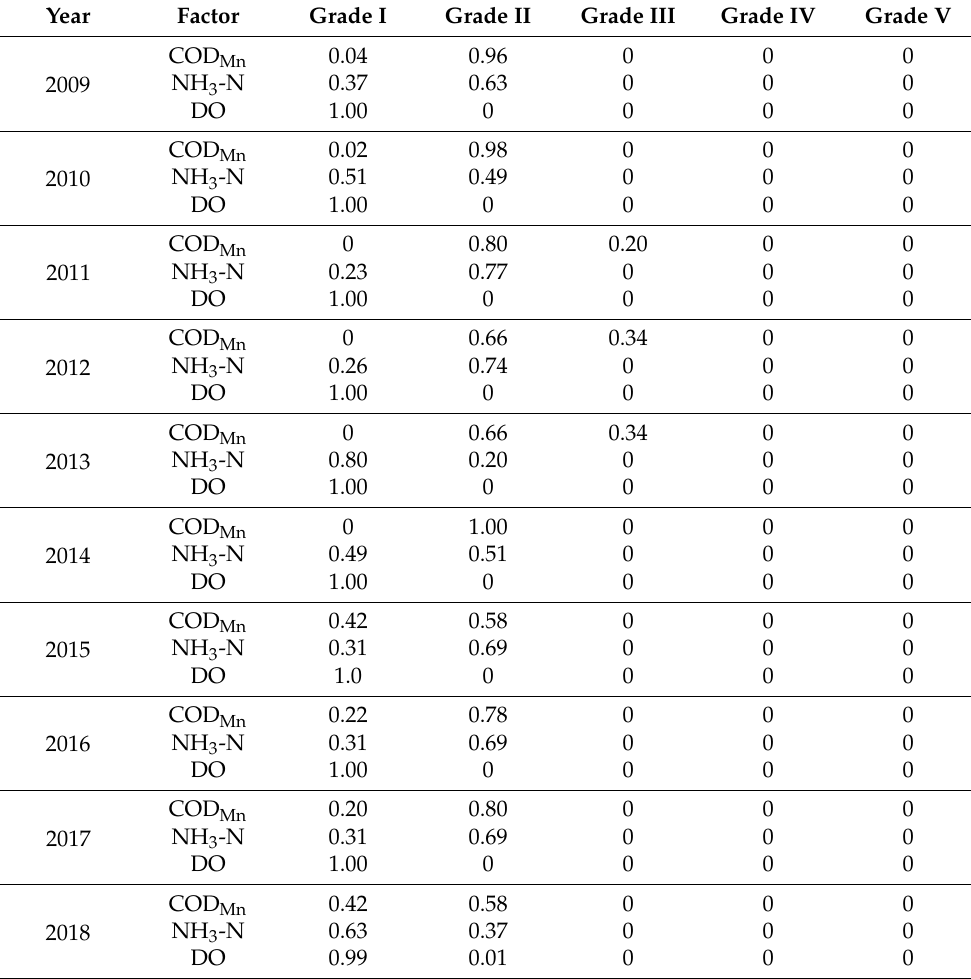
Table A7. Fuzzy matrix of Xintanggang Station in Hu-zhou,